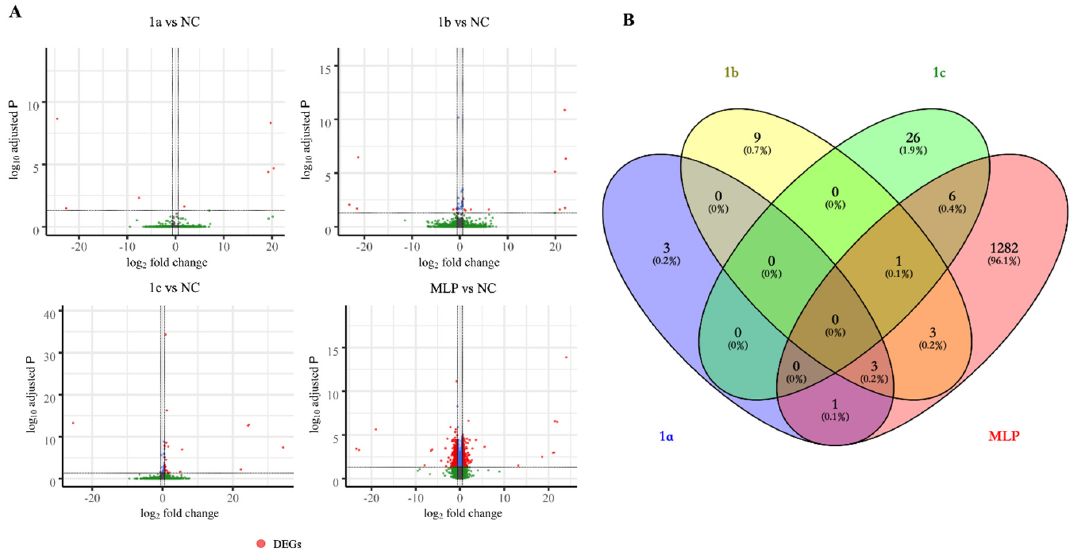
Figure 2. Comprehensive analysis of the RNA-seq results. ( A ) Volcano plots showing the differentially expressed genes (DEGs) identified from each LEG1 transgenic group versus their respective controls. The DEGs, indicated by red dots, were identified according to an adjusted p -value < 0.05 and |log 2 fold change| > 0.5849. ( B ) The Venn diagram of the DEGs shows that only a few genes were shared between groups.